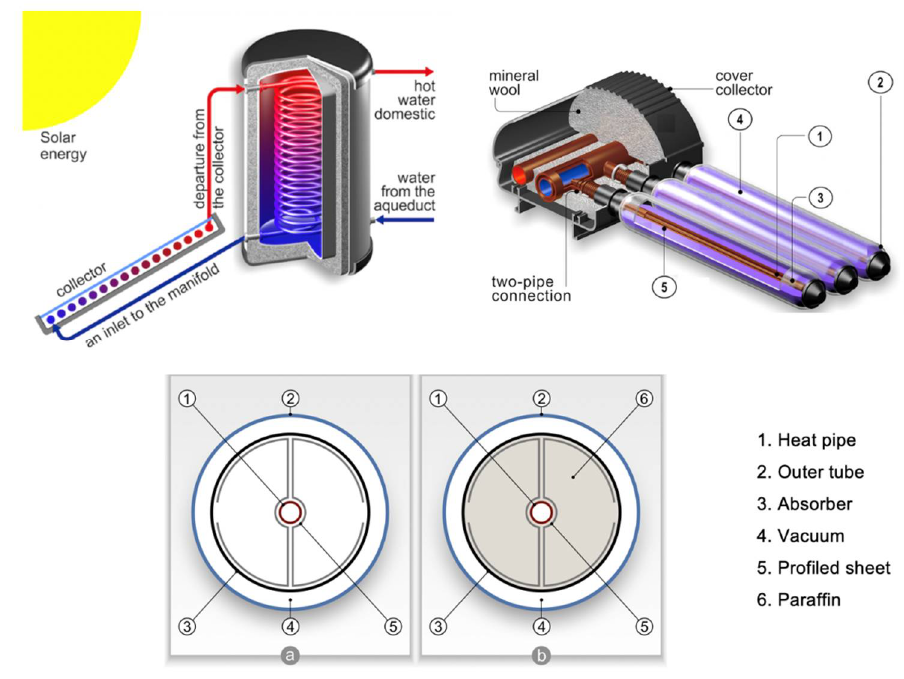
Figure 1. Scheme of the system: ( a ) ETC without PCM; ( b ) ETC/S integrated with PCM.